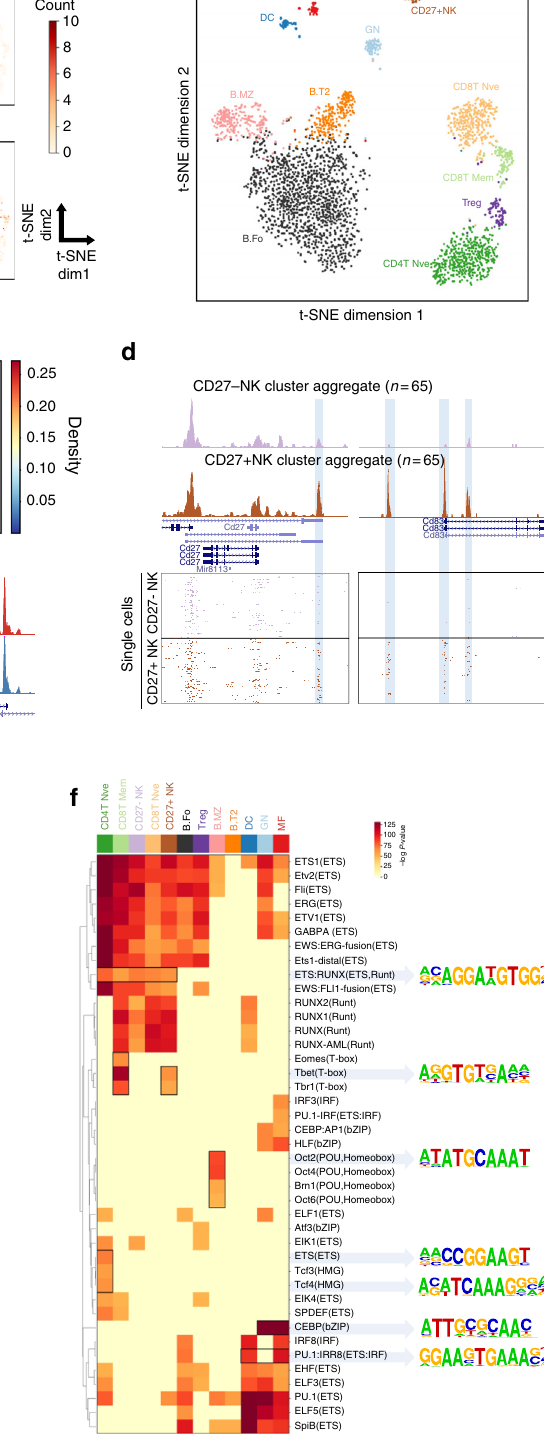
importantly, it is able to reveal key gene regulatory features, such as cell-type-speci fi c open chromatin regions and transcription factor motifs, in an unbiased manner. Future studies can utilise this method to unveil the regulatory characteristics of novel and rare cell populations and the mechanisms behind their tran- scriptional regulation. NATURE COMMUNICATIONS| (2018) 9:5345